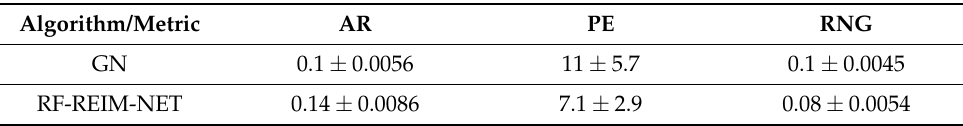
Table 2. Figures of merit for the tank experiment. The left number in each cell is the mean of the metric, while the right number is its std .